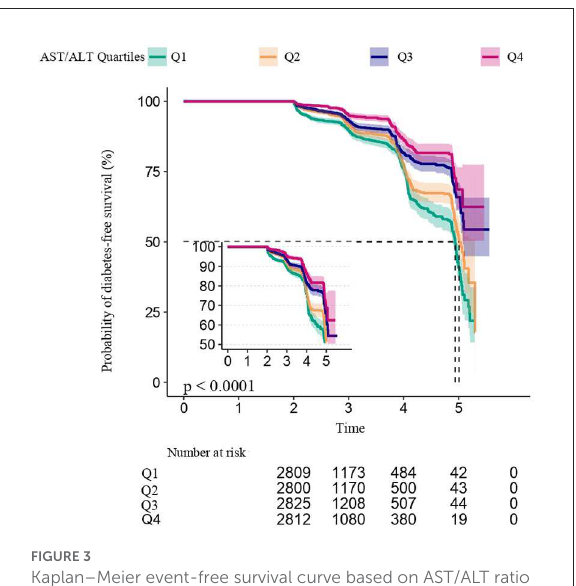
FIGURE3 Kaplan–Meier event-free survival curve based on AST/ALT ratio quartiles and the incidence of diabetes in prediabetic patients (log-rank, P < 0.0001). Each color of lines indicates a quintile group. The color range indicates the 95% confidence interval (CI) range of cumulative incidence of diabetes at a different follow-up